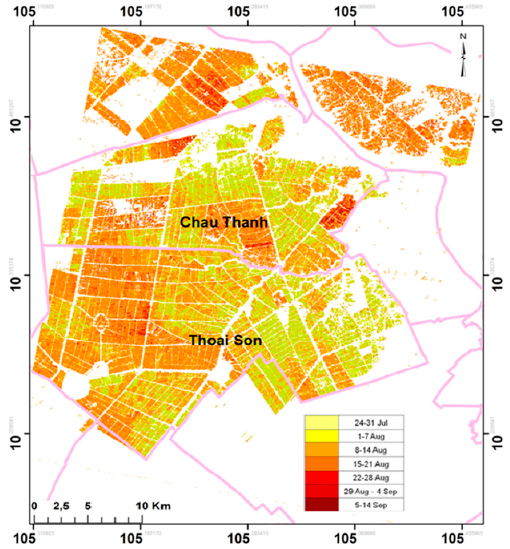
Figure 12. Sowing date map in Autumn-Winter crop in Chau Thanh and Thoai Son districts, An Giang Province.